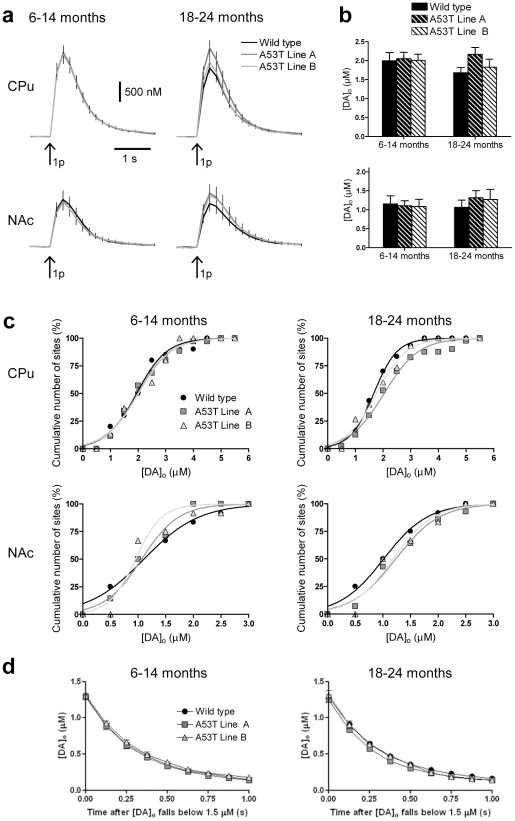
A53Tα-syn overexpression does not affect [DA]o evoked by a single stimulus pulse.(a) Profiles of mean [DA]o± SEM versus time, after single pulse stimulation (arrow). There was no significant difference in [DA]o between genotypes, at either age or in either region (n = 15–40 (CPu), n = 6–14 (NAc)). There was also no significant difference in mean peak [DA]o between 6–14 and 18–24 month mice of any genotype (n = 15–40 (CPu), n = 6–14 (NAc)). (b) Mean peak [DA]o± SEM evoked by a single pulse. (c) Cumulative distribution plots of peak [DA]o (µM) evoked by a single stimulation pulse. Curve fits are sigmoidal variable slope curves, R2>0.93. Curves are not significantly different between genotypes at 6–14 months in CPu or at either age in NAc, but are significantly different in CPu at 18–24 months. (d) Mean decay phases of concentration-matched DA transients in CPu do not differ between genotypes (n = 9–28).